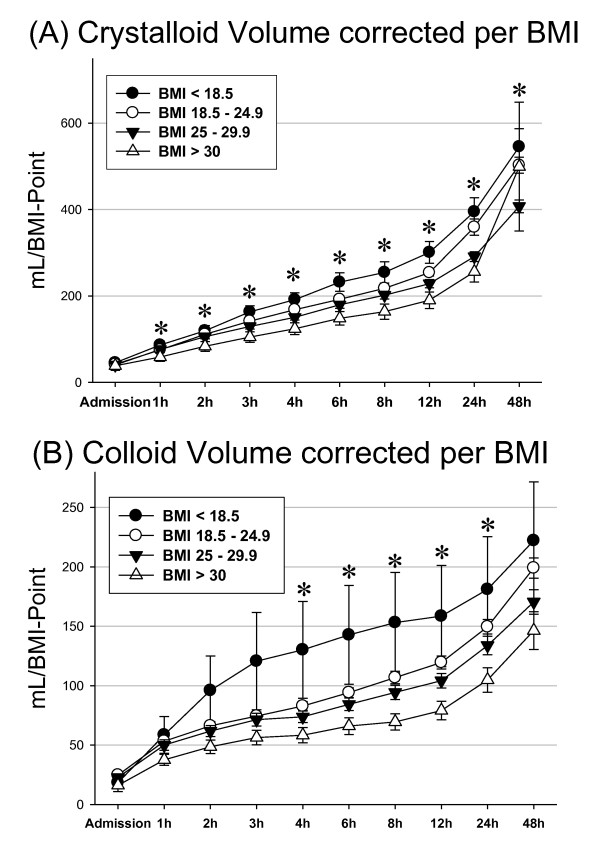
Crystalloid and colloid volume per body mass index point. Amount of (A) crystalloid volume and (B) colloid volume corrected for body mass index (BMI) point (total amount/number of BMI points) per BMI group. Error bars indicate the standard error of the mean. *Significant differences between patients with BMI of 18.5 to 24.9 compared with patients with BMI > 30.